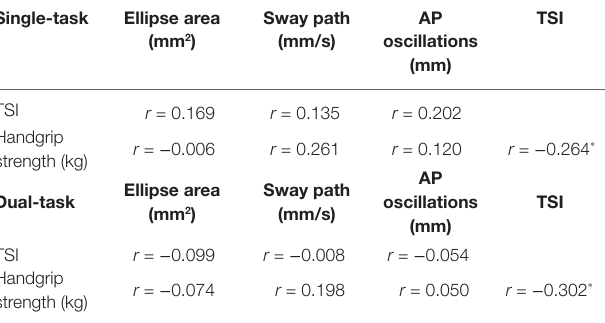
TABLE 2 | Pearson’s correlations among parameters obtained from static postural balance test, dynamic postural balance test, and handgrip strength test. Single-task